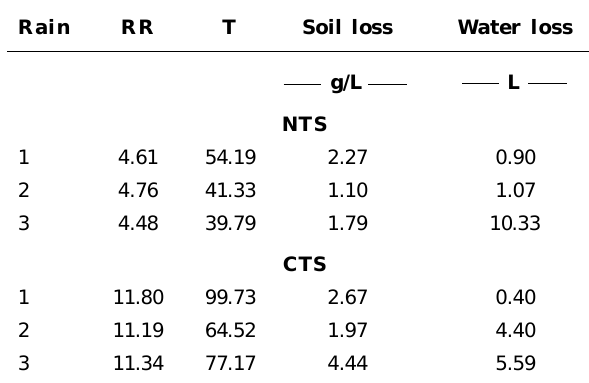
NTS : no-tillage soil; CTS: conventionally tilled soil